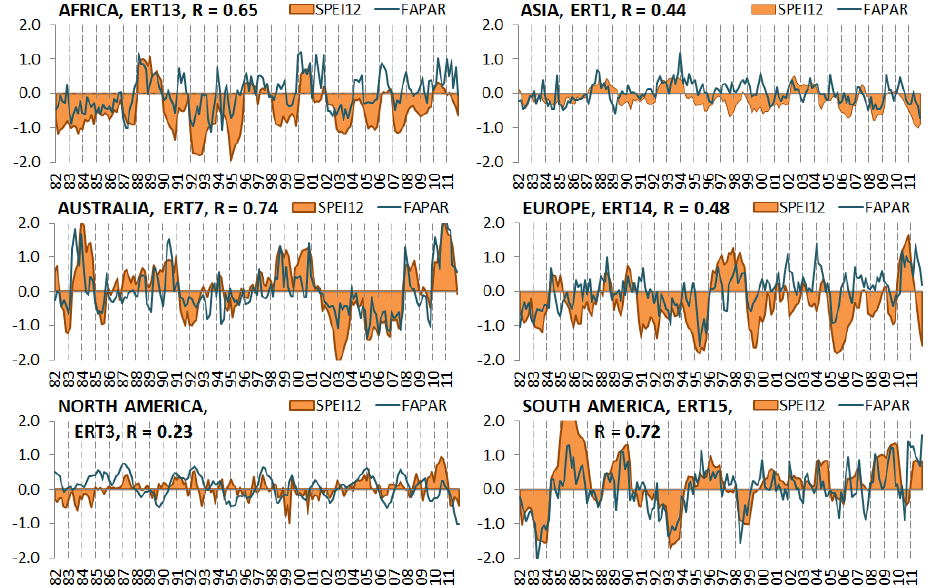
Figure 6. Temporal profiles of SPEI12 and FPAR3g anomalies in the ERTs with highest